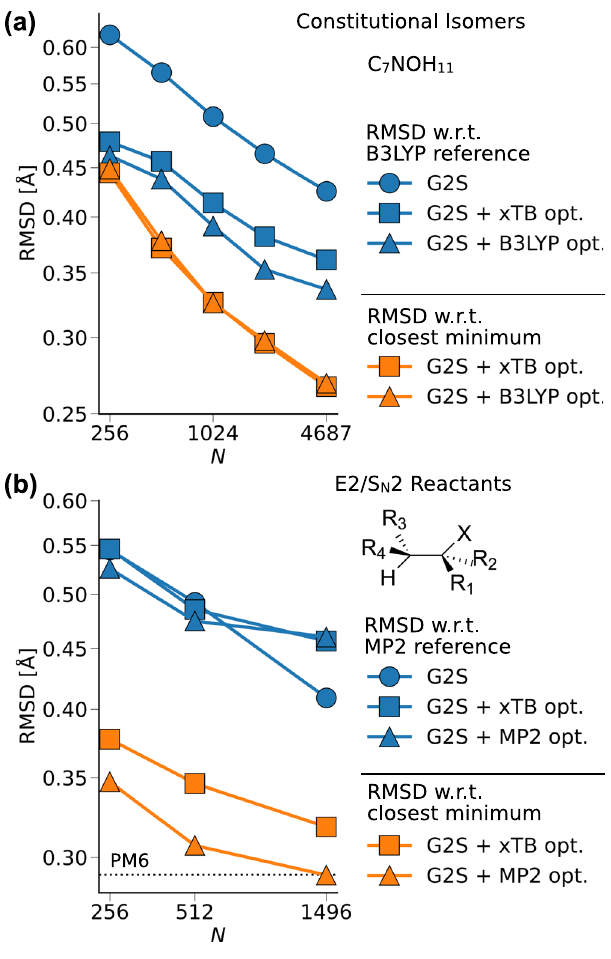
Fig. 5 Performance curves of G2S predicted structures after subsequent geometry optimization runs. Blue lines measure the RMSD w.r.t. a quantum-based reference structure (Fig. 4 error type A). Orange lines measure the RMSD w.r.t. G2S predicted structures after a structural relaxation (Fig. 4 error type B). All G2S predictions have been performed using the bond length representation. a C 7 NOH 11 constitutional isomers optimized with GFN2-xTB and B3LYP/6-31G(2df,p), respectively. b E2/S N 2 reactants optimized with GFN2-xTB and MP2/6-311G(d), respectively. The level of theory has been chosen according to the method used in each